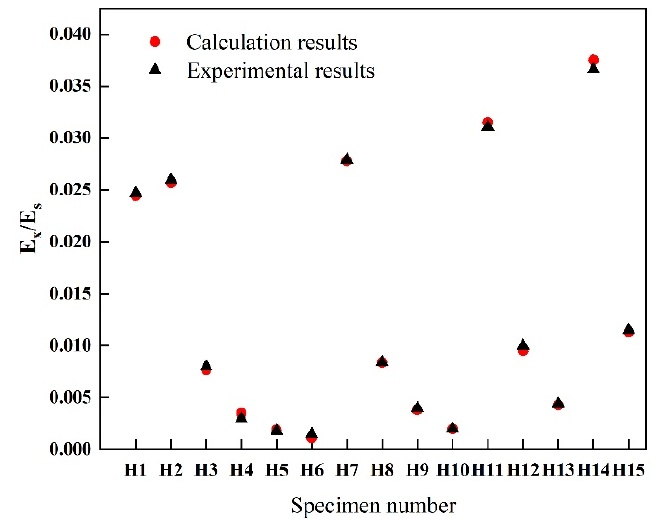
Figure 6. Experimental and theoretical predictions for the nondimensional Young’s modulus.